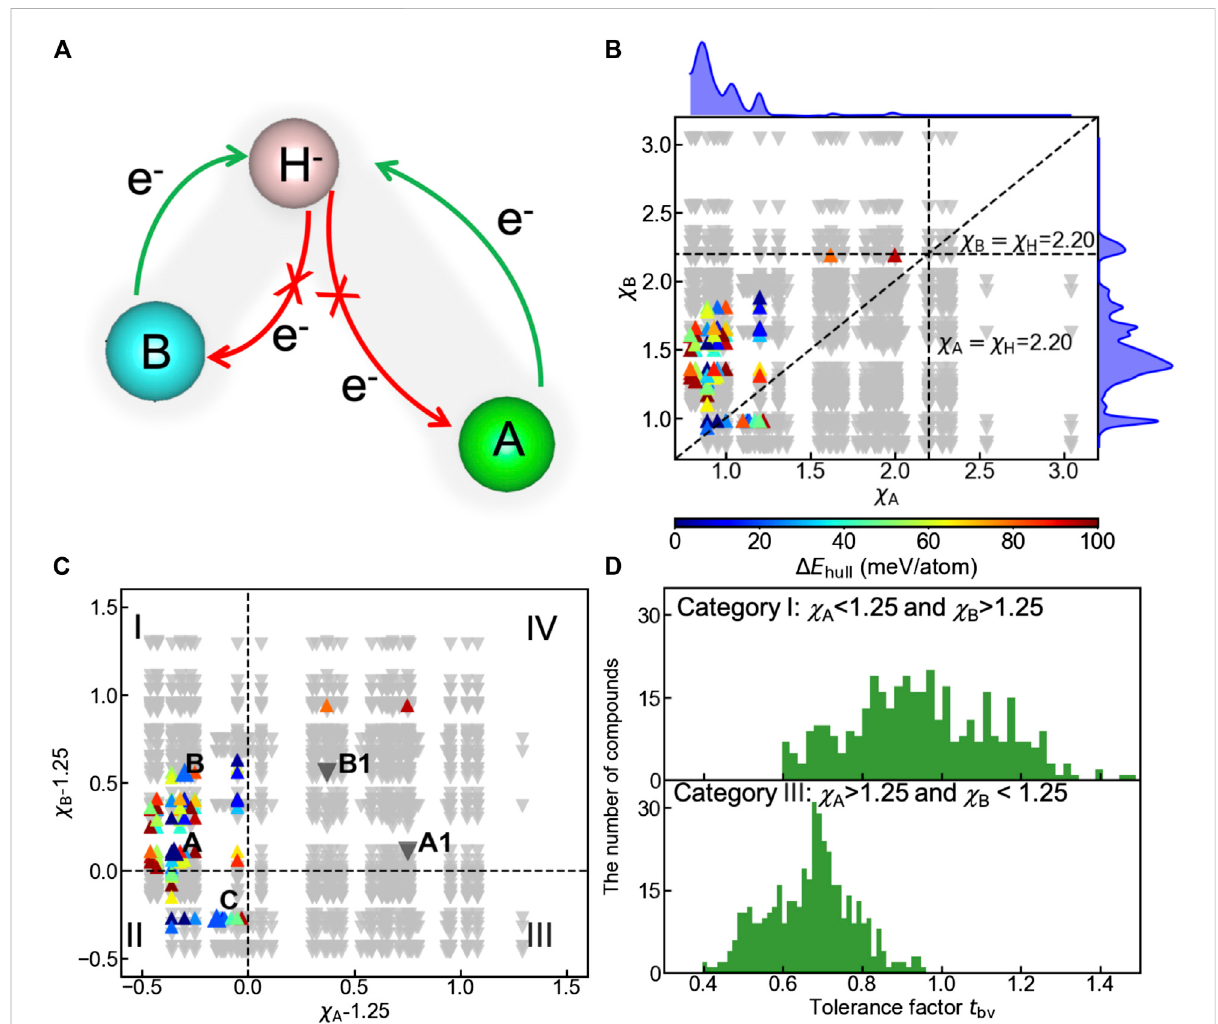
FIGURE 7 (A) Schematic of the charge transfer in hydride bonding to stabilize the oxyhydrides, with bond length of A-H longer than that of B-H. (B) StructuremapoftheoxyhydridesexhibitingtheelectronegativityofanelementatAsite( χ A )vsthatatBsite( χ B ).Theupperandrightcurvesrepresent the distribution of meta/stable oxyhydrides as a function of χ A and χ B , respectively. (C) Structure map of the oxyhydrides with χ A -1.25 vs χ B -1.25. The structure map is categorized into four parts (I, II, III and IV) with respect to the threshold of χ = 1.25. Five representative oxyhydrides are highlighted, i.e., (A) Ba 2 ScHO 3 ( Δ E hull = 0 meV/atom), A1: Hg 2 ScHO 3 ( Δ E hull = 366 meV/atom), (B) Sr 2 GaHO 3 ( Δ E hull = 22 meV/atom), B1: Tl 2 GaH 3 O ( Δ E hull = 199 meV/atom) and (C) La 2 LiHO 3 ( Δ E hull = 20 meV/atom). Up-pointing triangles indicate stable and metastable oxyhydrides ( Δ E hull ≤ 100 meV/atom), which are colored as a function of Δ E hull . Down-pointing triangles indicate unstable oxyhydrides ( Δ E hull > 100 meV/atom). (D) Distribution of t bv for the oxyhydrides belonging to category I and III in Figure 7C, respectively.